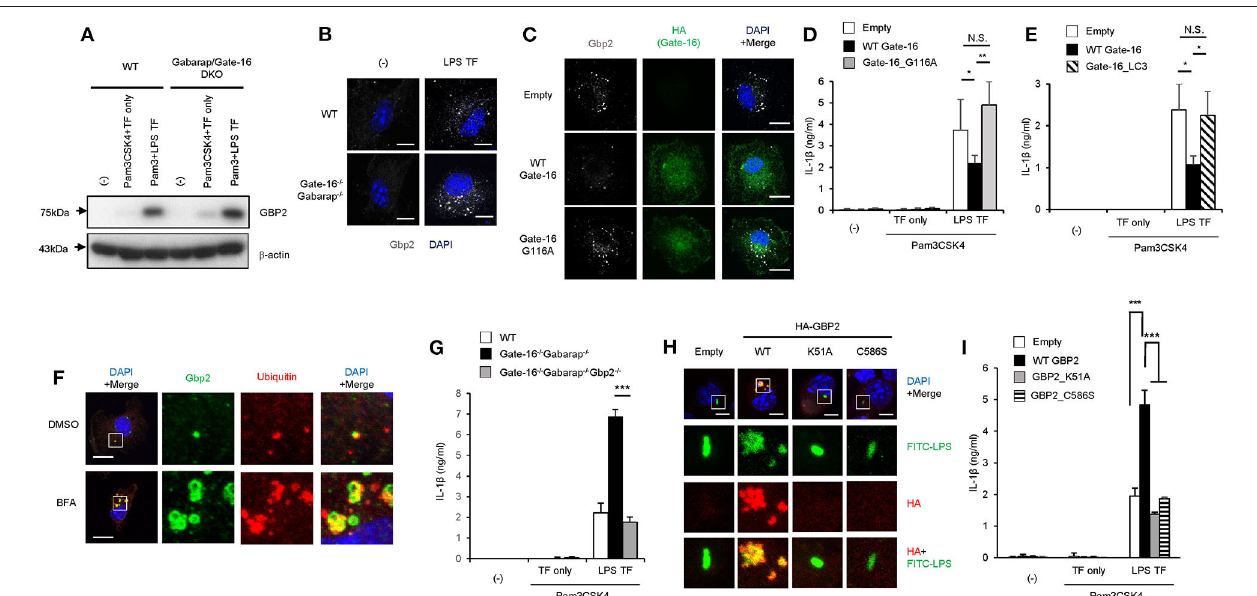
FIGURE 5 | GBP2-dependent enhanced caspase-11-dependent responses by Gate-16 /Gabarap deficiency. (A) Immunoblots of the indicated protein expressions in WT and Gate-16 − / − Gabarap − / − BMDMs primed with Pam3CSK4 followed by LPS or mock transfection for 16h. (B) Fluorescence confocal microscopy of wild-type (WT) and Gate-16 − / − Gabarap − / − BMDMs stimulated by LPS transfection for 6h and immunostained for GBP2 (white). The nucleus was stained with DAPI (blue). Scale bars correspond to 5 µ m. (C) Fluorescence confocal microscopy of Gate-16 − / − Gabarap − / − BMDMs stably expressing HA-tagged wild-type Gate-16 (WT Gate-16), the G116A mutant (G116A Gate-16) and empty vectors. The cells were stimulated by LPS transfection for 6h and immunostained for GBP2 (white) and HA (green). The nucleus was stained with DAPI (blue). Scale bars correspond to 10 µ m. (D,E) Release of IL-1 β from Gate-16 − / − Gabarap − / − BMDMs stably expressing wild-type Gate-16 (WT Gate-16), empty vector, the G116A mutant (Gate-16_G116A) (D) or the defective Arf1 binding mutant (Gate-16_LC3) (E) . The cells were primed with Pam3CSK4 and subsequently stimulated by LPS transfection for 16h. (F) Fluorescence confocal microscopy of IFN- β -stimulated wild-type BMDMs untreated or treated with Brefeldin A (BFA, 35 µ M) for 1h and immunostained for GBP2 (green) and ubiqutin (red). The nucleus was stained with DAPI (blue). Scale bars correspond to 5 µ m. (G) Release of IL-1 β (G) from wild-type (WT), Gate-16 − / − Gabarap − / − and Gate-16 − / − Gabarap − / − Gbp2 − / − BMDMs primed with Pam3CSK4 followed by LPS transfection for 16h. (H) Fluorescence confocal microscopy of Pam3CSK4-primed Gate-16 − / − Gabarap − / − Gbp2 − / − BMDMs stably expressing HA-tagged wild-type GBP2 (WT), the GTPase-inactive mutant (K51A), the non-isoprenylated mutant (C586S) and empty vectors, subsequently stimulated by FITC-LPS (green) transfection for 2h and immunostained for HA (red). The nucleus was stained with DAPI (blue). Scale bars correspond to 5 µ m. (I) Release of IL-1 β from Gate-16 − / − Gabarap − / − Gbp2 − / − BMDMs stably expressing HA-tagged wild-type GBP2 (WT GBP2), the GTPase-inactive mutant (GBP2_K51A), the non-isoprenylated mutant (GBP2_C586S) and empty vectors. The cells were primed with Pam3CSK4 and subsequently stimulated by LPS transfection for 16h. The data are representative of three independent experiments (A–C,F,H) and are combined data of more than three independent experiments (D,E,G,I) . * P < 0.05, ** P